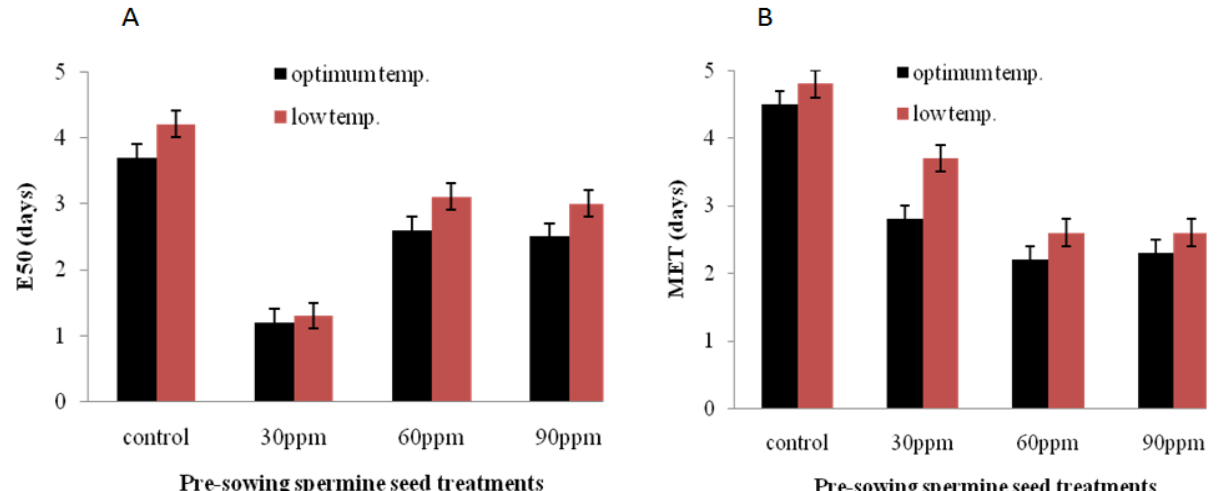
Fig. 1. Effect of spermine application on mean emergence time (MET) (A) and E50 (B) of maize seedlings under optimum and low temperature conditions. Data are the mean value of three replications ± SE which represented by the vertical bar in each